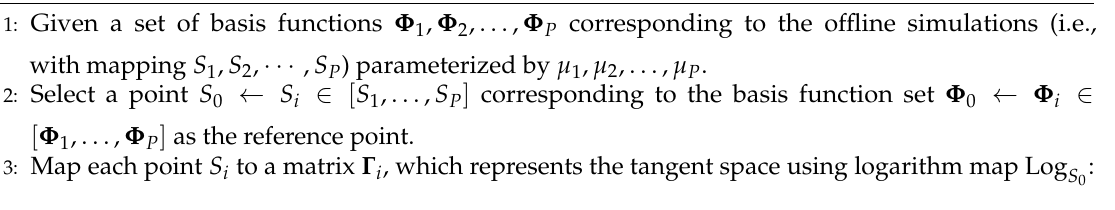
Figure 2. An illustration of the Grassmann manifold interpolation procedure to construct basis functions for a new testing condition. Algorithm 1 Grassmann manifold